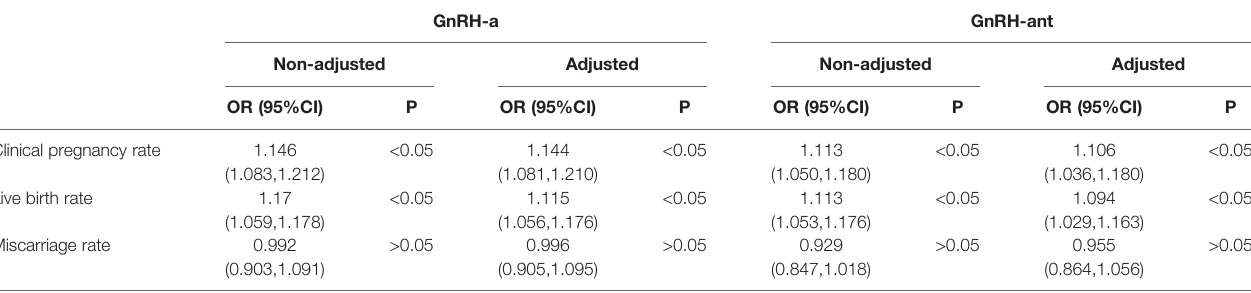
TABLE 6 | Logistics regression analysis of endometrial thickness and clinical